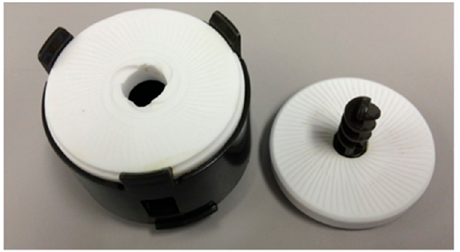
Figure 5. A set of ceramic mill set in a tea maker.